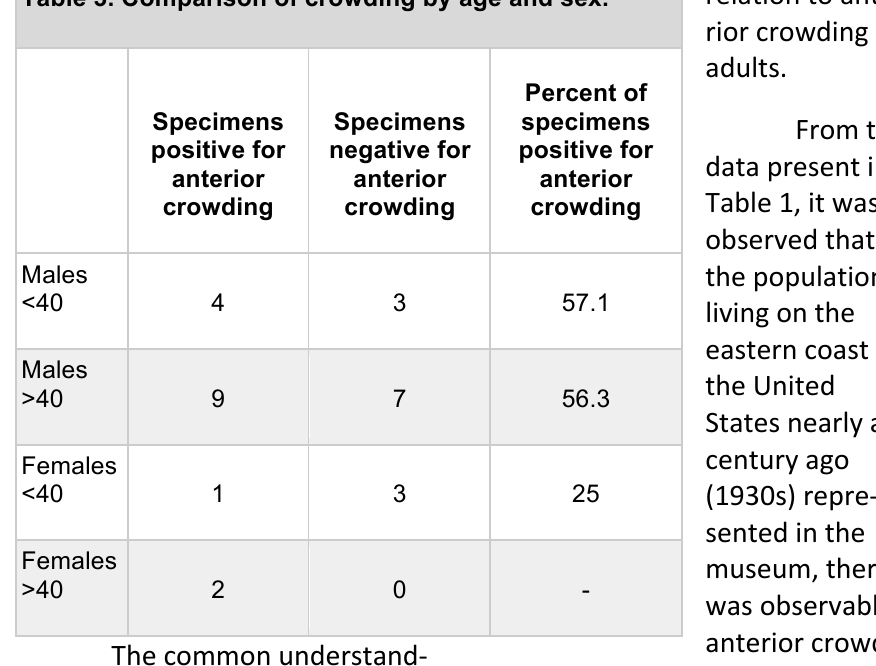
Table 3. Comparison of crowding by age and sex.